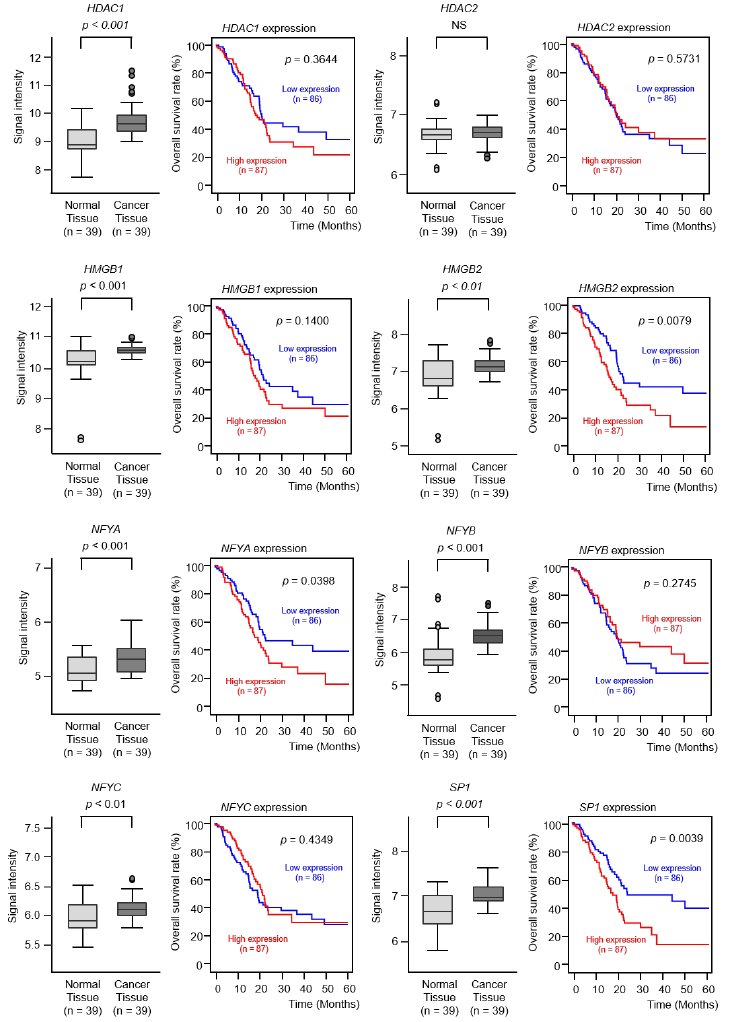
Figure 8. Expression levels and clinical significance of TOP2A transcriptional regulators by TCGA analyses. The expression levels of 8 genes ( HDAC1, HDAC2, HMGB1, HMGB2, NFYA, NFYB, NFYC , and SP1 ) involved in TOP2A transcriptional regulation were evaluated by TCGA database